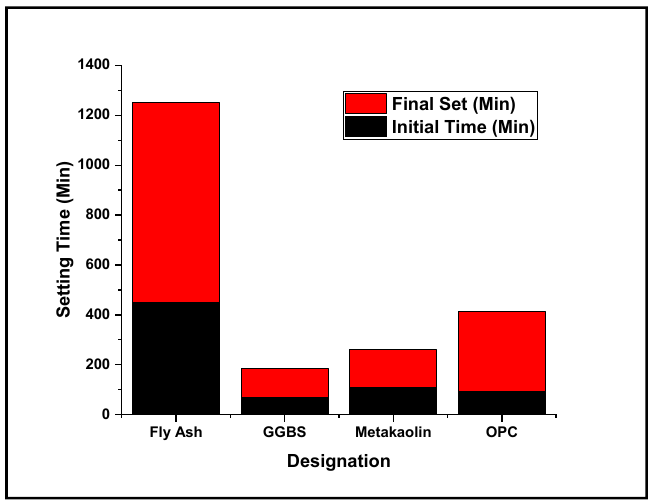
Figure 6. Initial & Final-setting time of pastes.